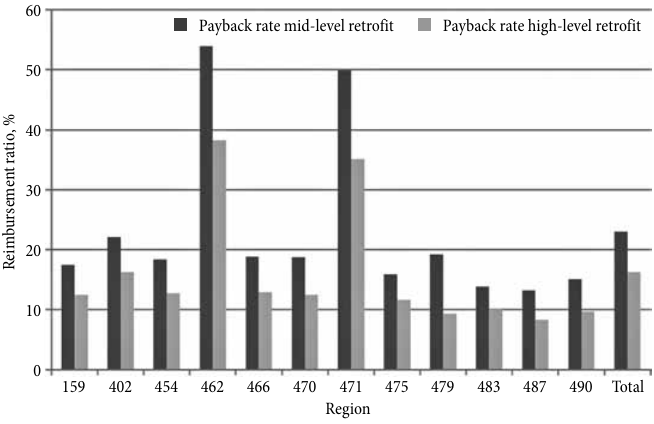
Fig. 3. Estimation of reimbursement ratio ( h = 50%, i =